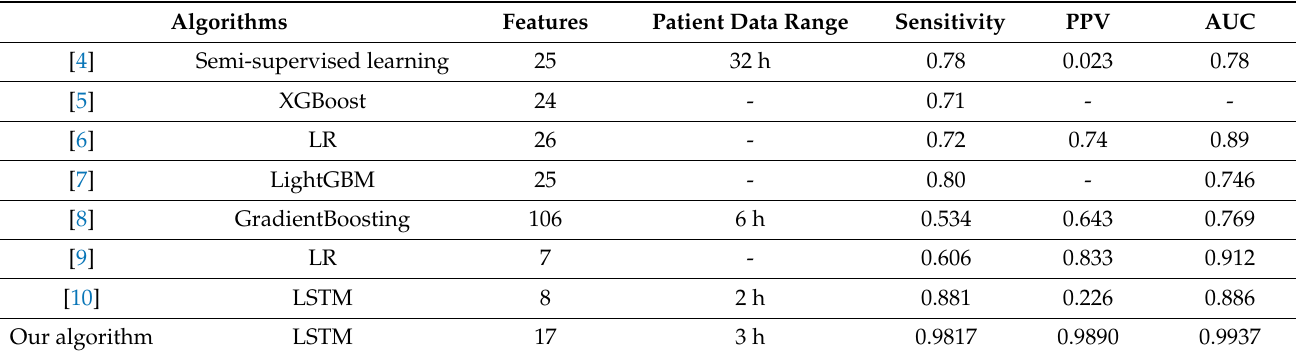
Table 12. Comparison of the performance between the proposed algorithm and algorithms in other